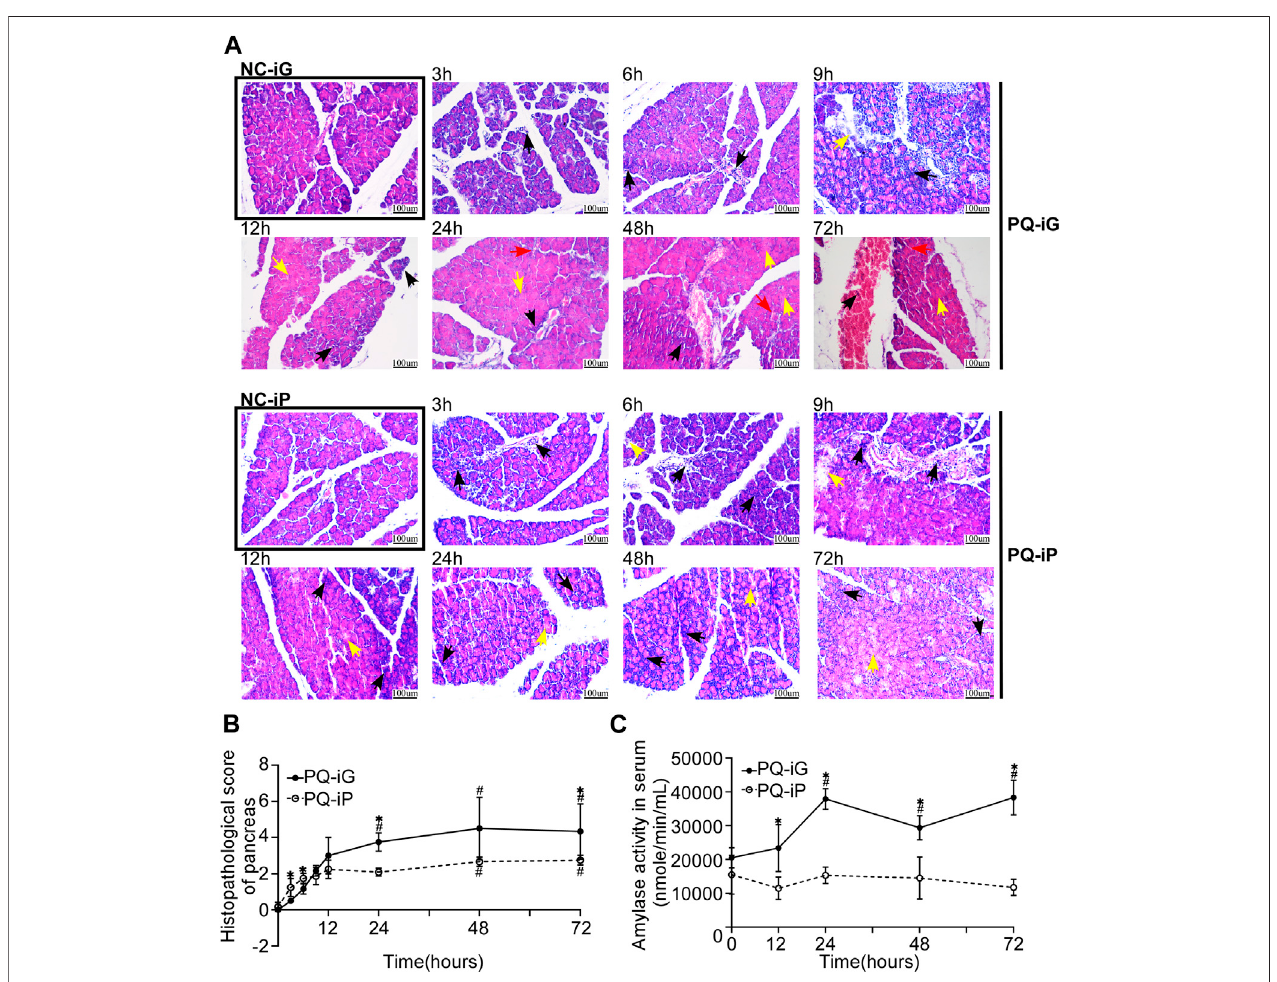
FIGURE 2 | Changes in the pancreas due to iG and iP administration of PQ. (A) Typical pathological changes in H&E stained pancreatic tissue sections in groups PQ-iG and PQ-iP at various times of observation (magni fi cation × 200; scale bar: 100 μ m; black arrow (cid:1) in fl ammatory cell in fi ltration; yellow arrow (cid:1) necrotic cell; red arrow (cid:1) hemorrhage); (B) Pathological damage scores of rat pancreas in groups PQ-iG and PQ-iP at each observation time point; (C) Serum amylase activity ( nmole/ min/ ml)ofratsingroupsPQ-iGandPQ-iP.ThecorrespondingNC-groupsvaluesweretakenfor0 hafterPQtreatment.* p < 0.05:thedifferencebetweenthePQ- iG and PQ-iP groups was statistically signi fi cant at this time point; # p < 0.05: the difference was statistically signi fi cant in comparison with the corresponding NC group. PQ paraquat; iG: intragastric infusion; iP: intraperitoneal